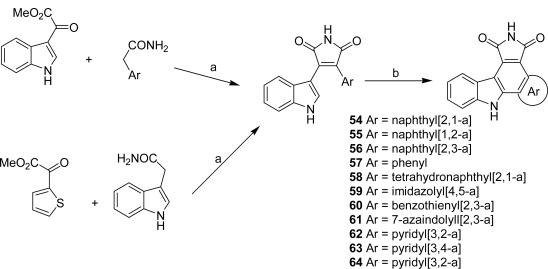
(a) t-BuOK, THF, 0°C to rt. (b) benzene, hν, reflux or dioxane, DDQ, hν, reflux or acetone, hν, 35 °C or Pd(OAc)2, AcOH.